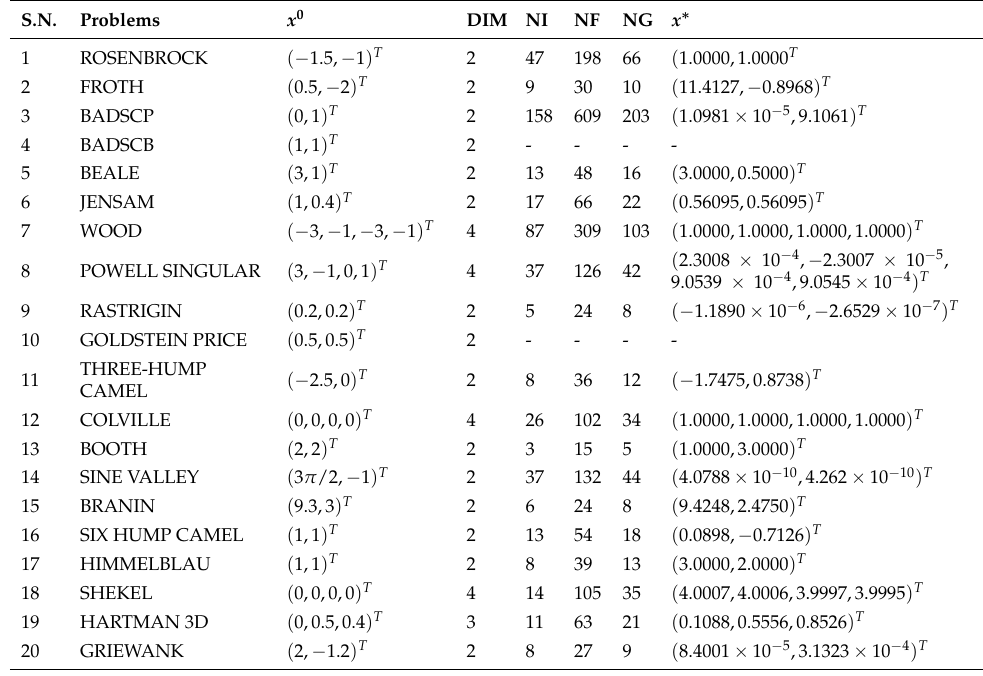
Table 8. Numerical results for q -BFGS